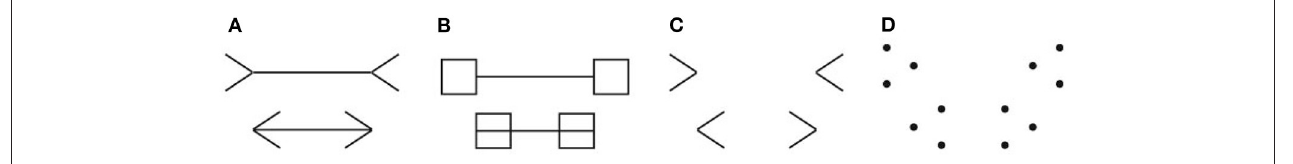
FIGURE 4 | The Müller-Lyer illusion (A) and variations (B–D) (Howe and Purves, 2005, p.